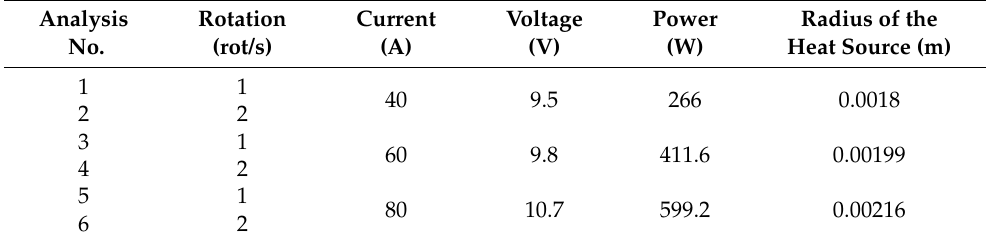
Table 1. Summary of parameters of numerical simulations carried out.